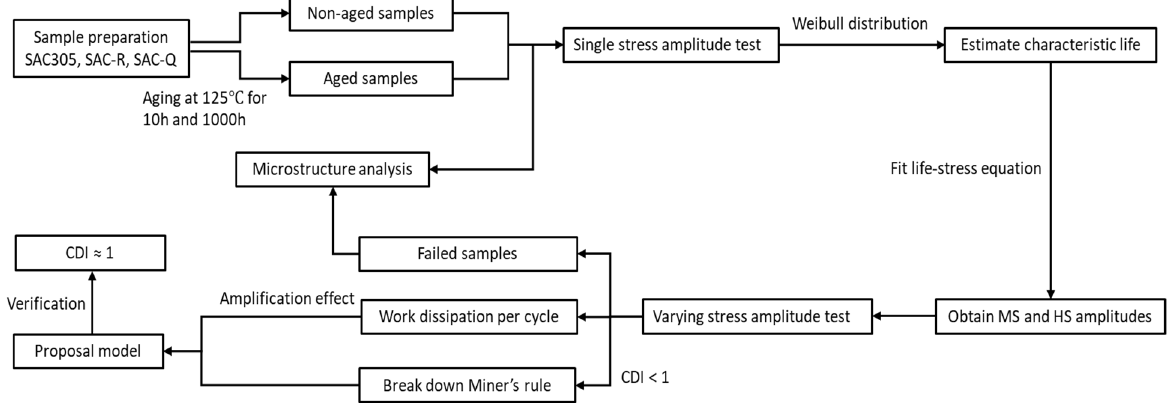
Figure 5. Block diagram of the of the experimental tests.